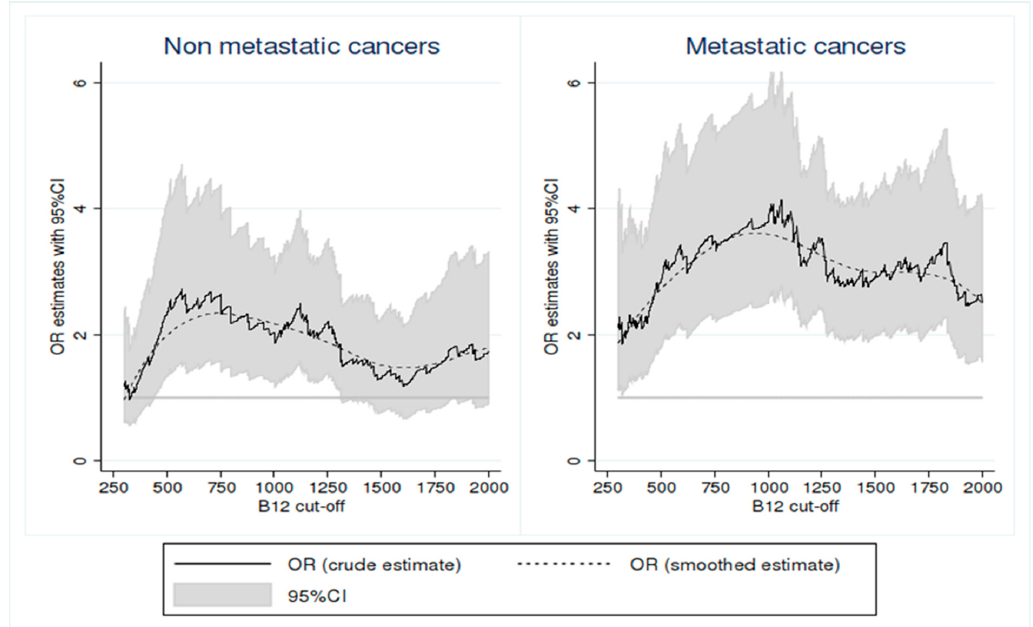
Figure 1. Strength of the association between solid cancers with and without metastases and elevated vitamin B12 levels. Notes: Graphics present the adjusted OR illustrating the association between solid cancer and elevated vitamin B12 levels for all values of vitamin B12 between 300 and 2000 ng/L. For each tested threshold, the OR represented the association between elevated B12 and solid cancers by comparing patients with B12 concentration above this threshold with those having B12 concentration below this threshold (and not with a single reference group of patients with normal B12). These two analyses are independent. For each analysis, cancer without metastases in the left panel and with metastasis in the right panel was defined as a dichotomous variable (presence versus absence). The odds ratios are adjusted for